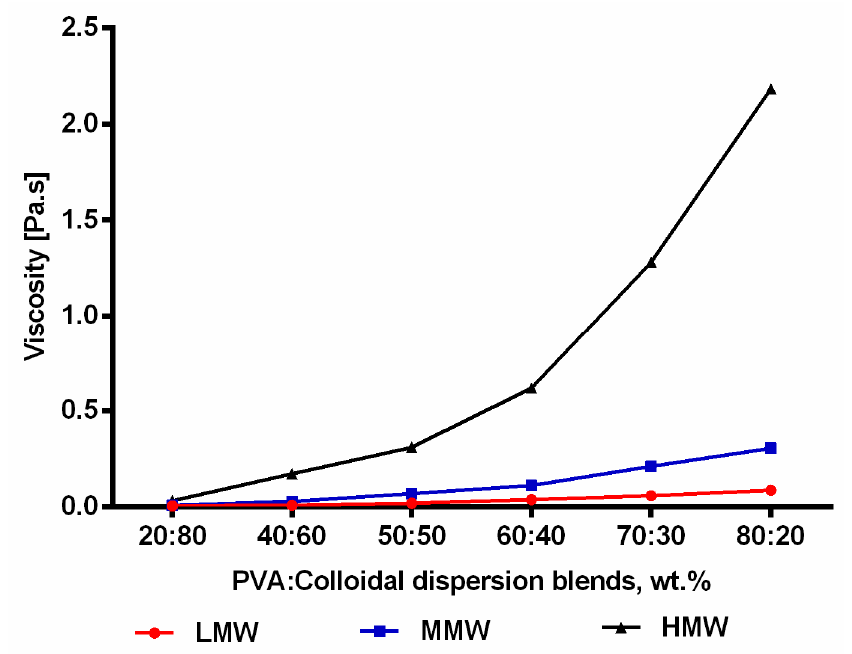
Figure 3. Viscosity as a function of PVA / colloidal dispersion aqueous blends (error bars are smaller than the symbol size).